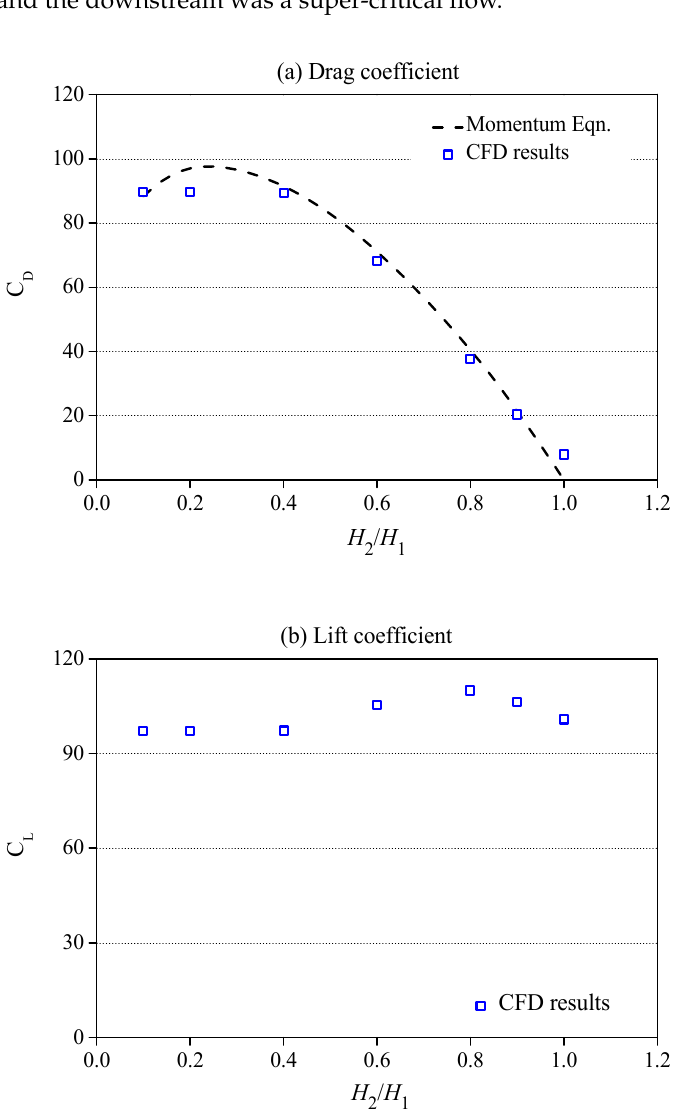
Figure 10. Relationship between the depth ratio and force coefficients ( a ) drag coefficient; ( b ) lift coefficient.